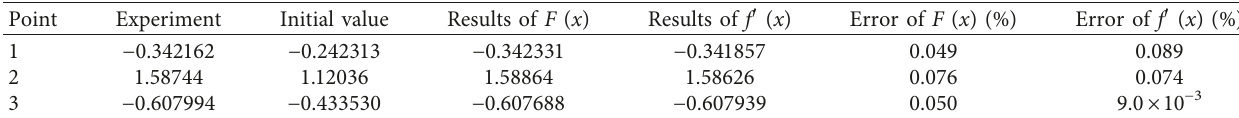
Table 7: Displacement of Y direction of the observed